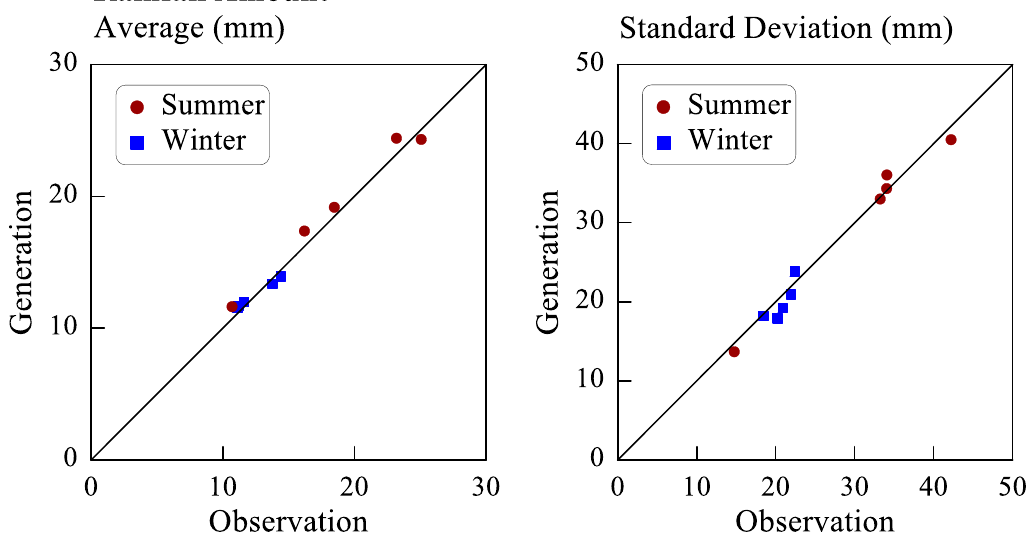
Figure 10. Comparison of the average and standard deviation values obtained for the observed and generated rainfall quantities.